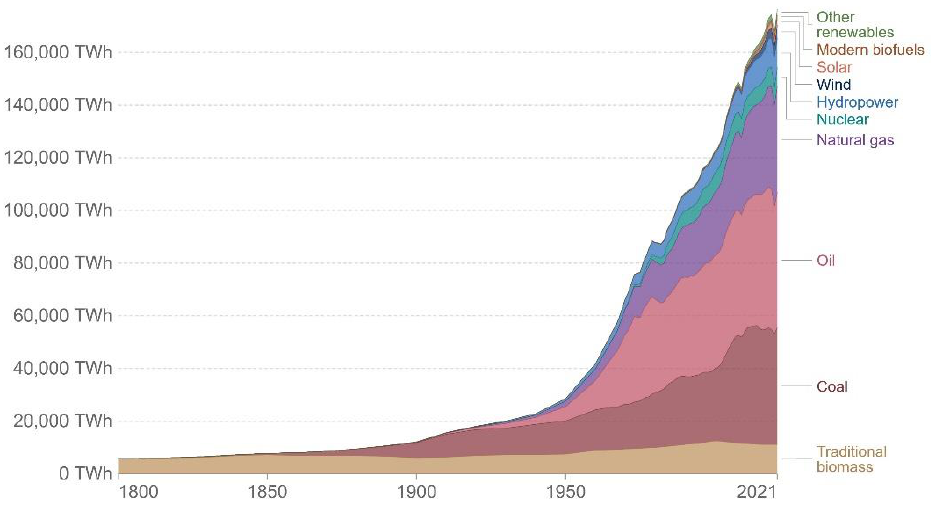
Figure 6. The global primary energy consumption by source (https://ourworldindata.org/energy- mix, accessed on 30 December 2022).